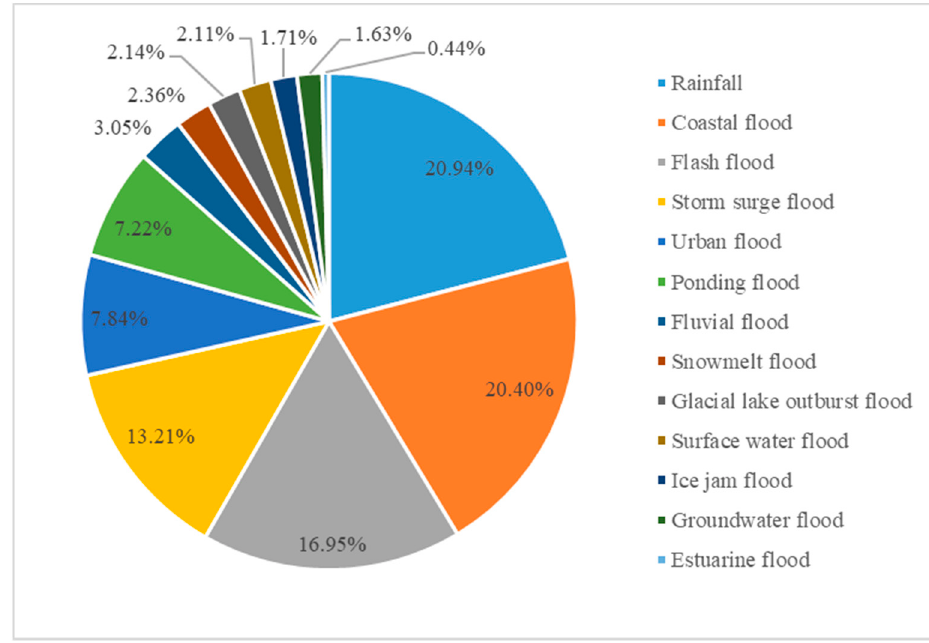
Figure 2. Quantitative statistics on flood disaster subcategories.